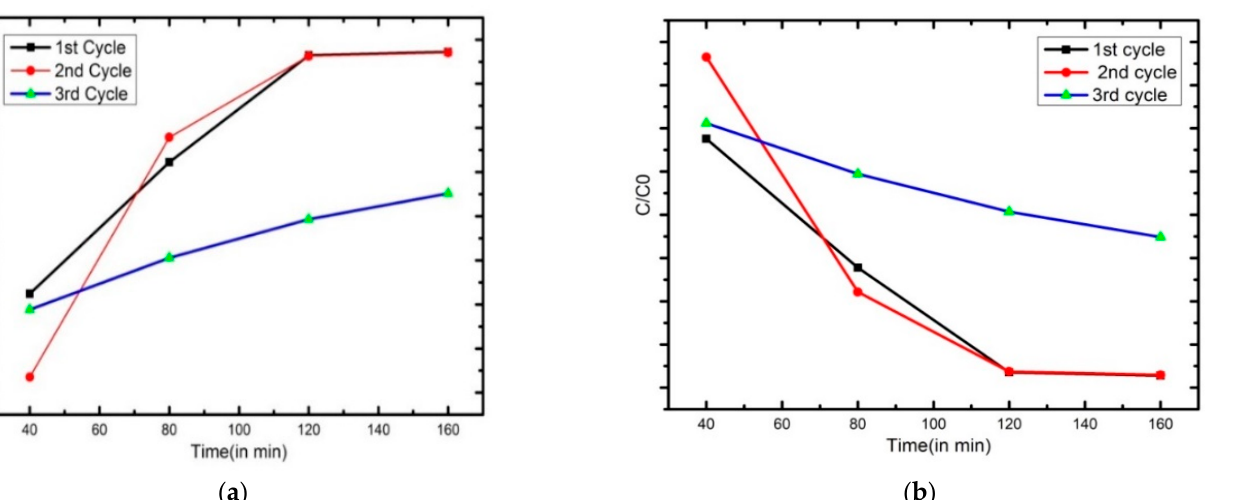
Figure 8. ( a ) Degradation pro fi le for 10 ppm ca ff eine after reusing the THB catalyst for three cycles. ( b ) Degradation e ffi ciency of 35 mg of THB for degrading 10 ppm ca ff eine solution for three cycles.